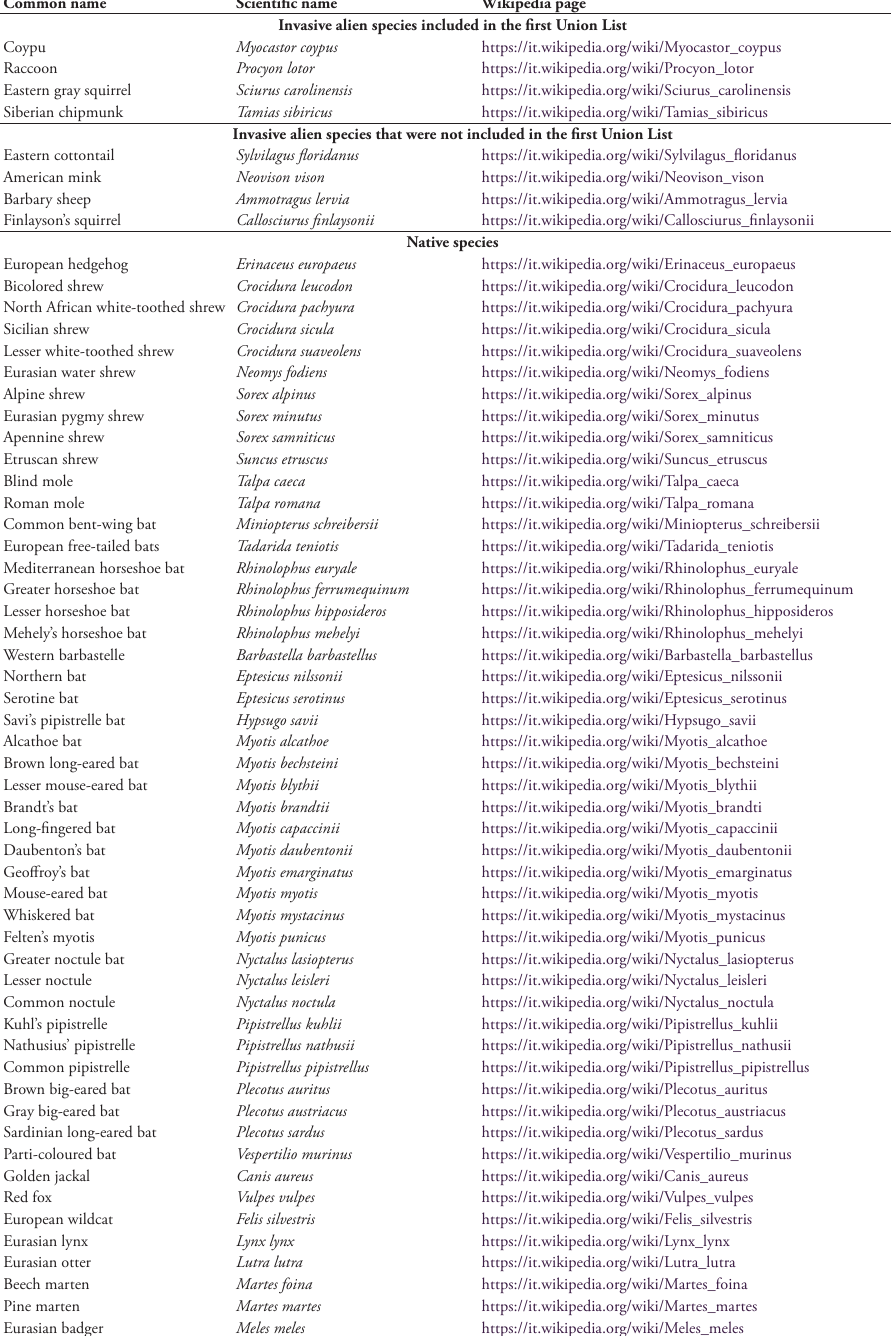
Table 1. List of invasive and native species of mammals that were considered for data analysis. Common